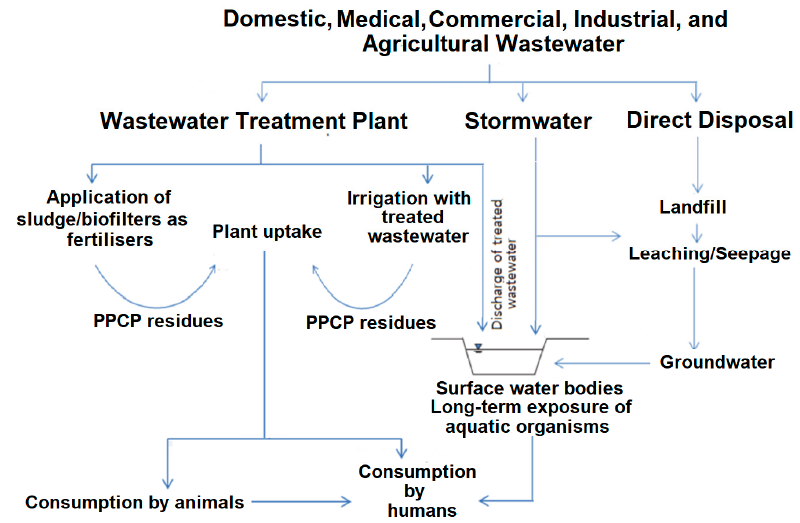
Figure 1. Sources and pathways of PPCP entry into the natural environment (modified from Reyes et al. [2]).